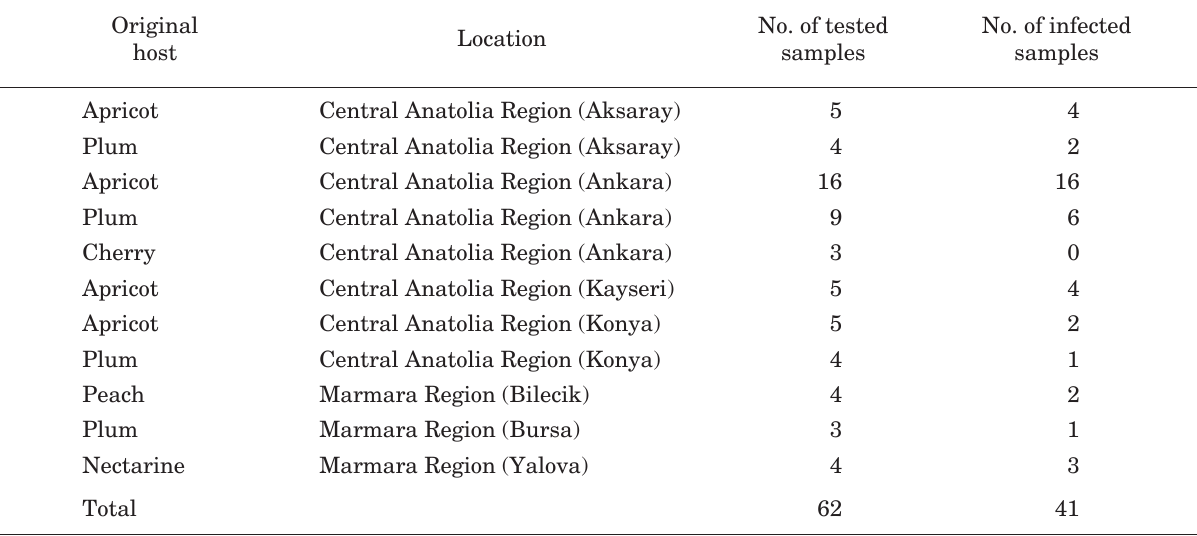
Table 4. Samples used for the RT-PCR